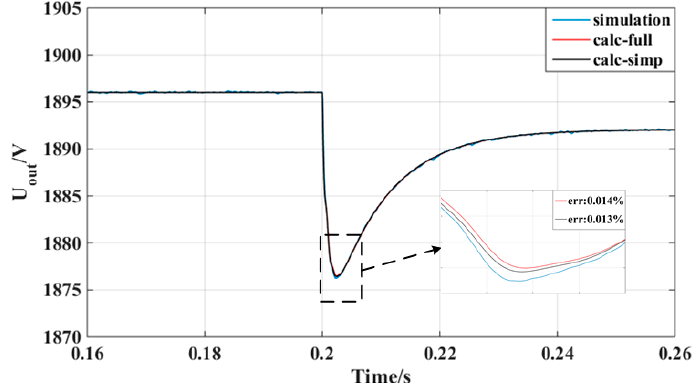
Energies 2019 , 12 , x FOR PEER REVIEW Figure 6. The waveform of output dc bus voltage (load step). Figure 6. The waveform of output dc bus voltage (load step).